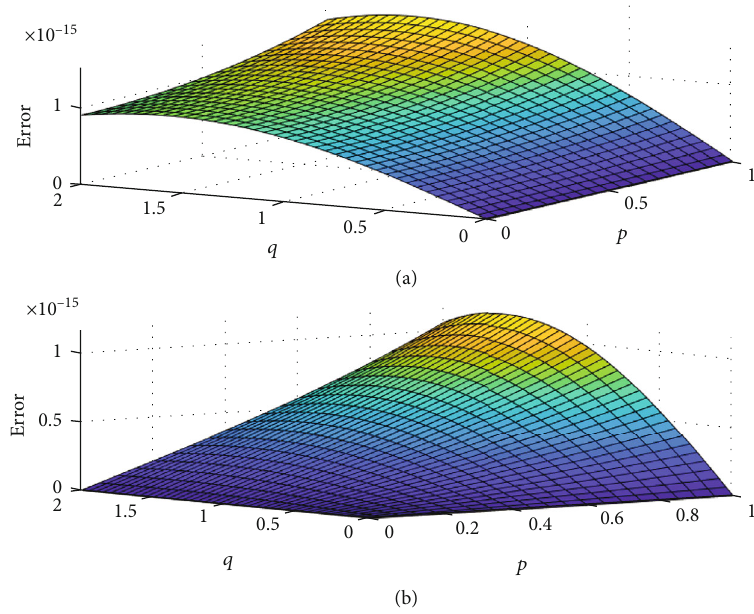
Figure 4: Charts of absolute error z (a) and v (b) with ρ = ω = υ = 1 for Example 8 when m = 6 .